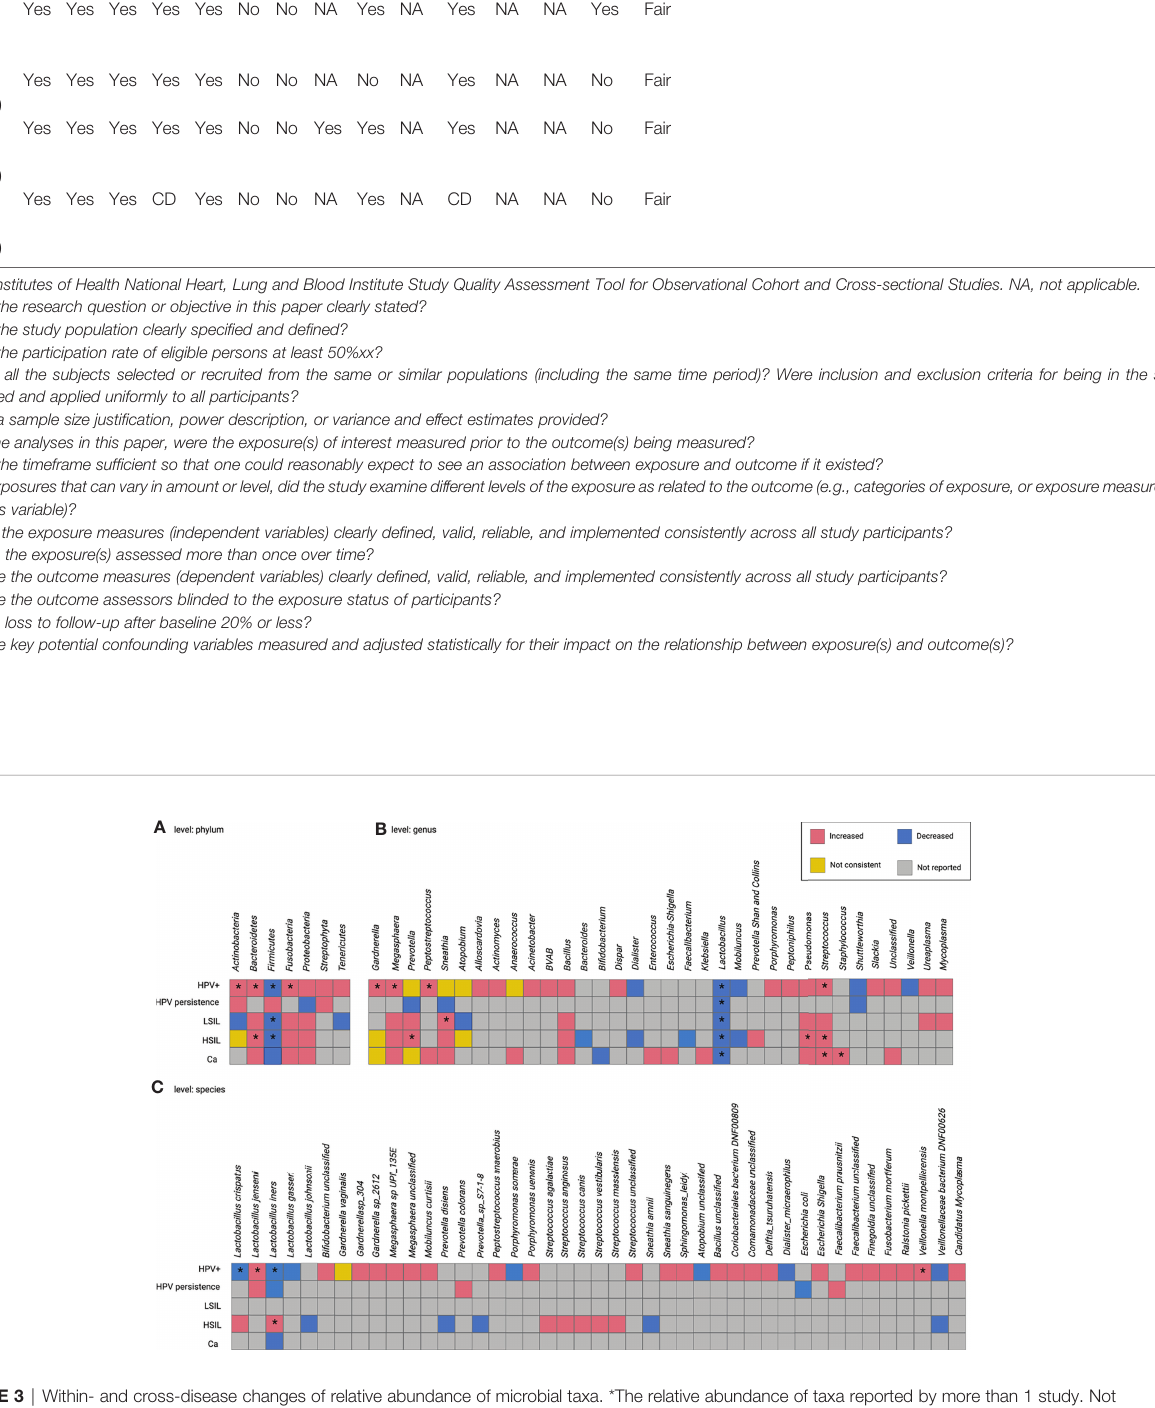
FIGURE 3 | Within- and cross-disease changes of relative abundance of microbial taxa. *The relative abundance of taxa reported by more than 1 study. Not consistent, any fi nding with less than 75% agreement between studies reporting this taxon. HPV+, HPV-positive women; LSIL, low-grade squamous intraepithelial lesions; HSIL; high-grade squamous intraepithelial lesions; CIN, cervical intraepithelial neoplasia; Ca, cervical